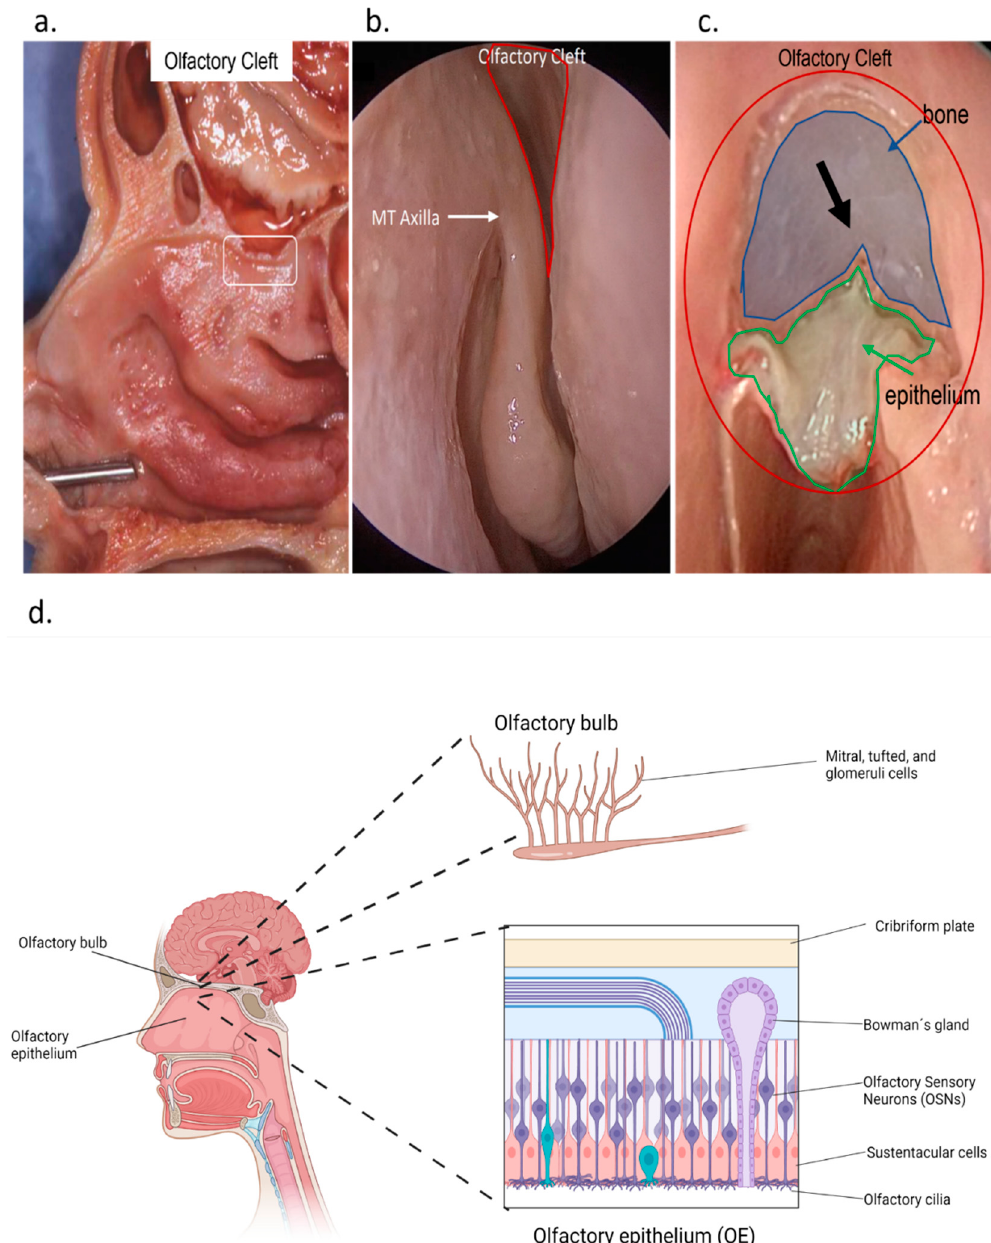
Figure 1. Human Olfactory Neuroepithelium; ( a ) Sagittal section of an anatomical specimen showing in the cranial portion of the nasal cavity (in the box) the area where the OE is positioned. The epithelium rests on the cribriform plate of the ethmoidal bone, which is crossed by the olfactory fibers which connect with the olfactory bulb; ( b ) endonasal view of the olfactory cleft (circled in red), the area where the OE is located (MT axilla—axilla of the middle turbinate); ( c ) endonasal vision after lifting the epithelium (circled in green) from the bone (circled in blue) to highlight the first olfactory fiber (black arrow); ( d ) schematic representation of the location and composition of the OE. ( a – c ) are taken by the Head and Neck Surgery & Forensic Dissection Research Center (HNS &